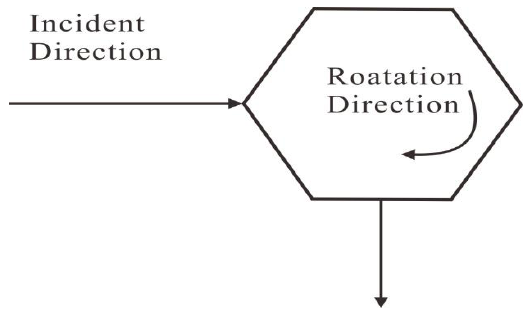
Figure3. Principle Diagram of Rotating Polyhedron